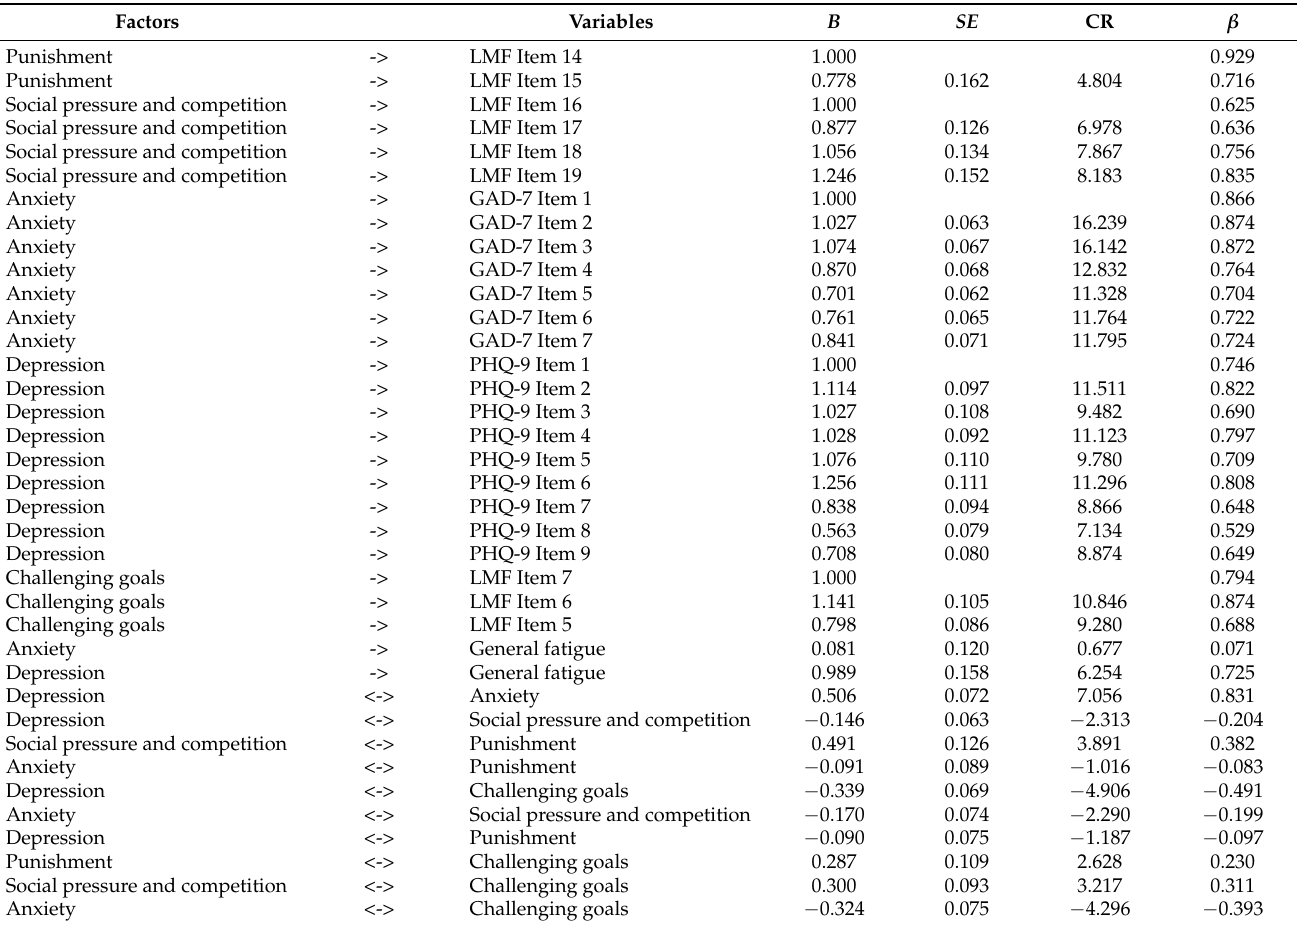
Table 15. Scalar estimates of the model of associations between learning motivating factors, anxiety, depression, and fatigue in the sample of participants of e-learning-based computer programming